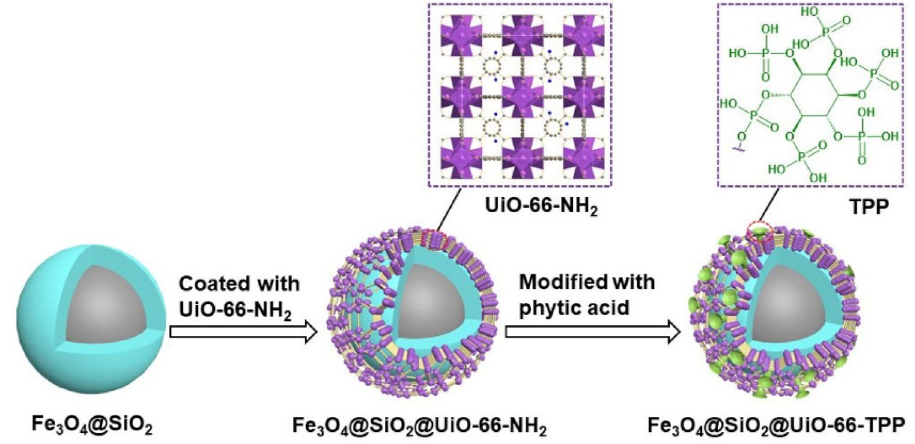
Figure 1. Schematic illustration of the fabrication of Fe 3 O 4 @SiO 2 @UiO-66-TPP